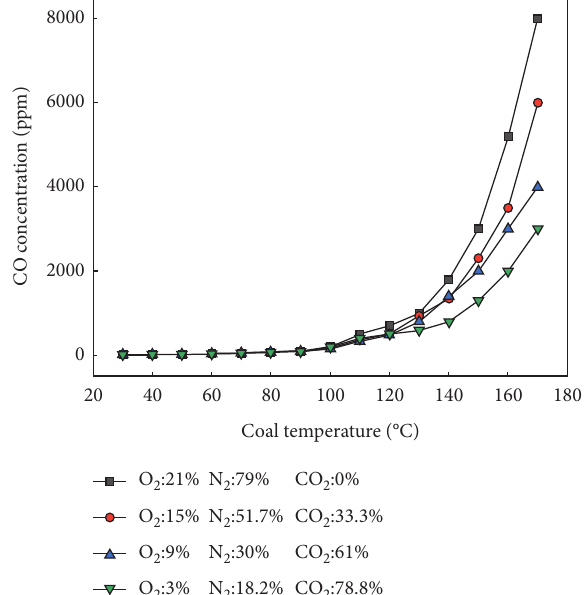
Figure 8: CO concentration as a function of coal temperature for experimental conditions 1–4 (Table